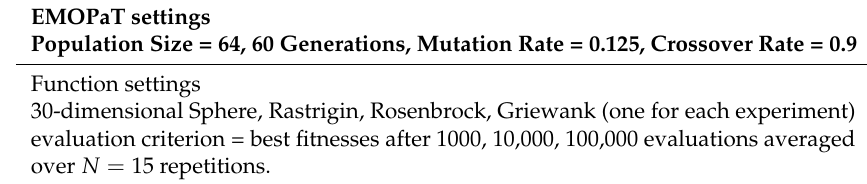
Table 2. Single-function optimization with different fitness evaluation budgets. Experimental settings. EMOPaT